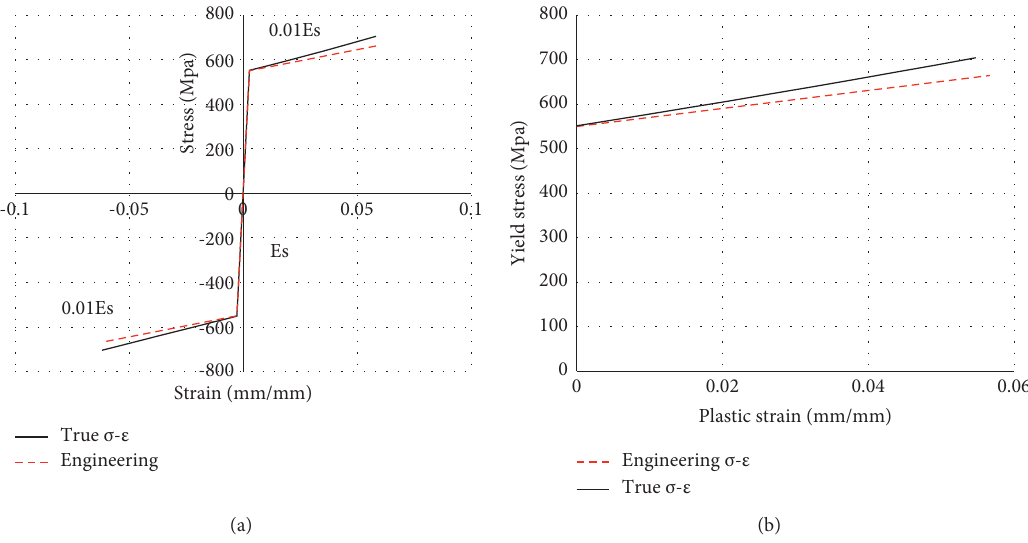
Figure 8: FE analysis steel bars material model. (a) Bilinear stress-strain relation. (b) Yield stress-plastic strain